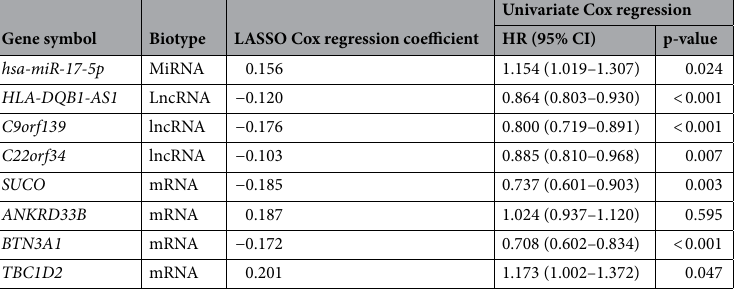
Table 2. CM prognosis-related immune molecules screened by LASSO Cox regression and univariate Cox regression. HR hazard ratio, 95% CI 95% confidence